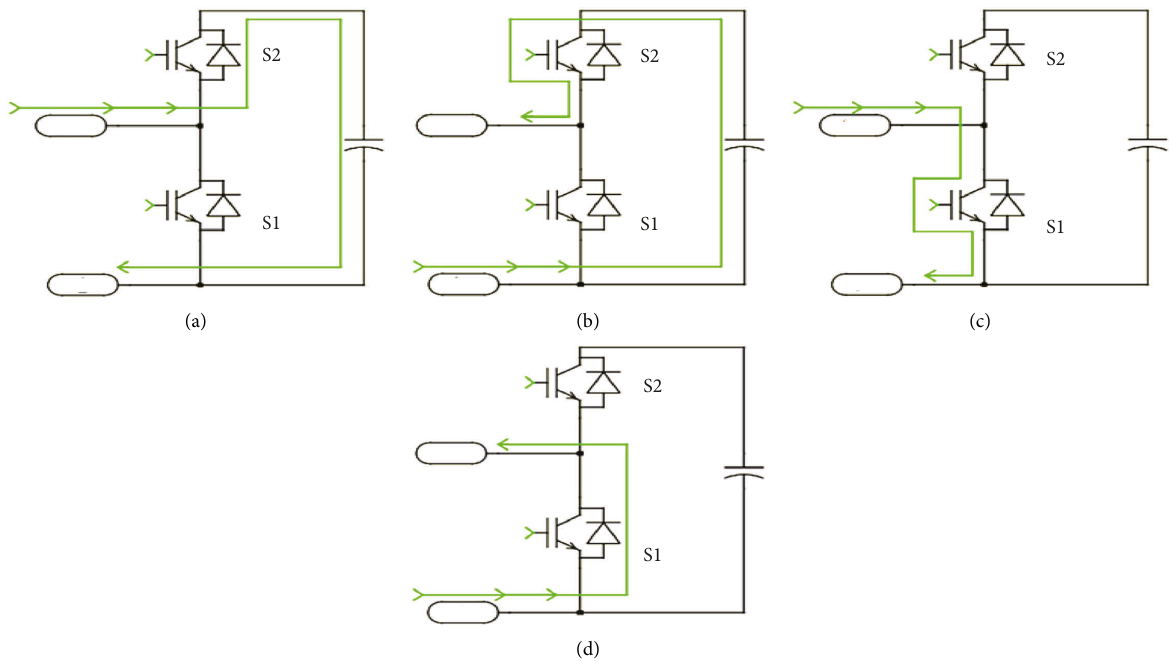
Figure 2: Different operating states of half bridge. (a) State_1, (b) State_2, (c) State_3, and (d)